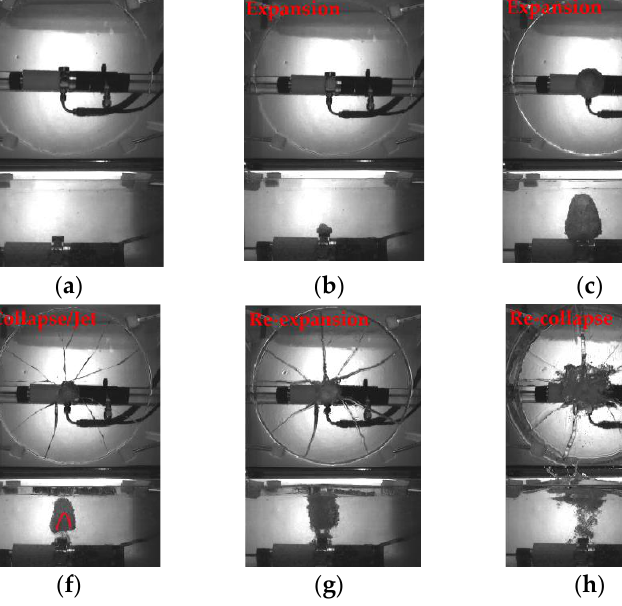
Figure 8. Images of icebreaking by an airgun bubble with T = 0.28 and H = 1.02. ( a ) t = 0 ms, ( b ) t = 0.60 ms, ( c ) t = 4.80 ms, ( d ) t = 8.65 ms, ( e ) t = 9.20 ms, ( f ) t = 9.90 ms, ( g ) t = 16.35 ms, ( h ) t = 69.10 ms, ( i ) t = 215.05 ms, ( j ) t = 423.95 ms.